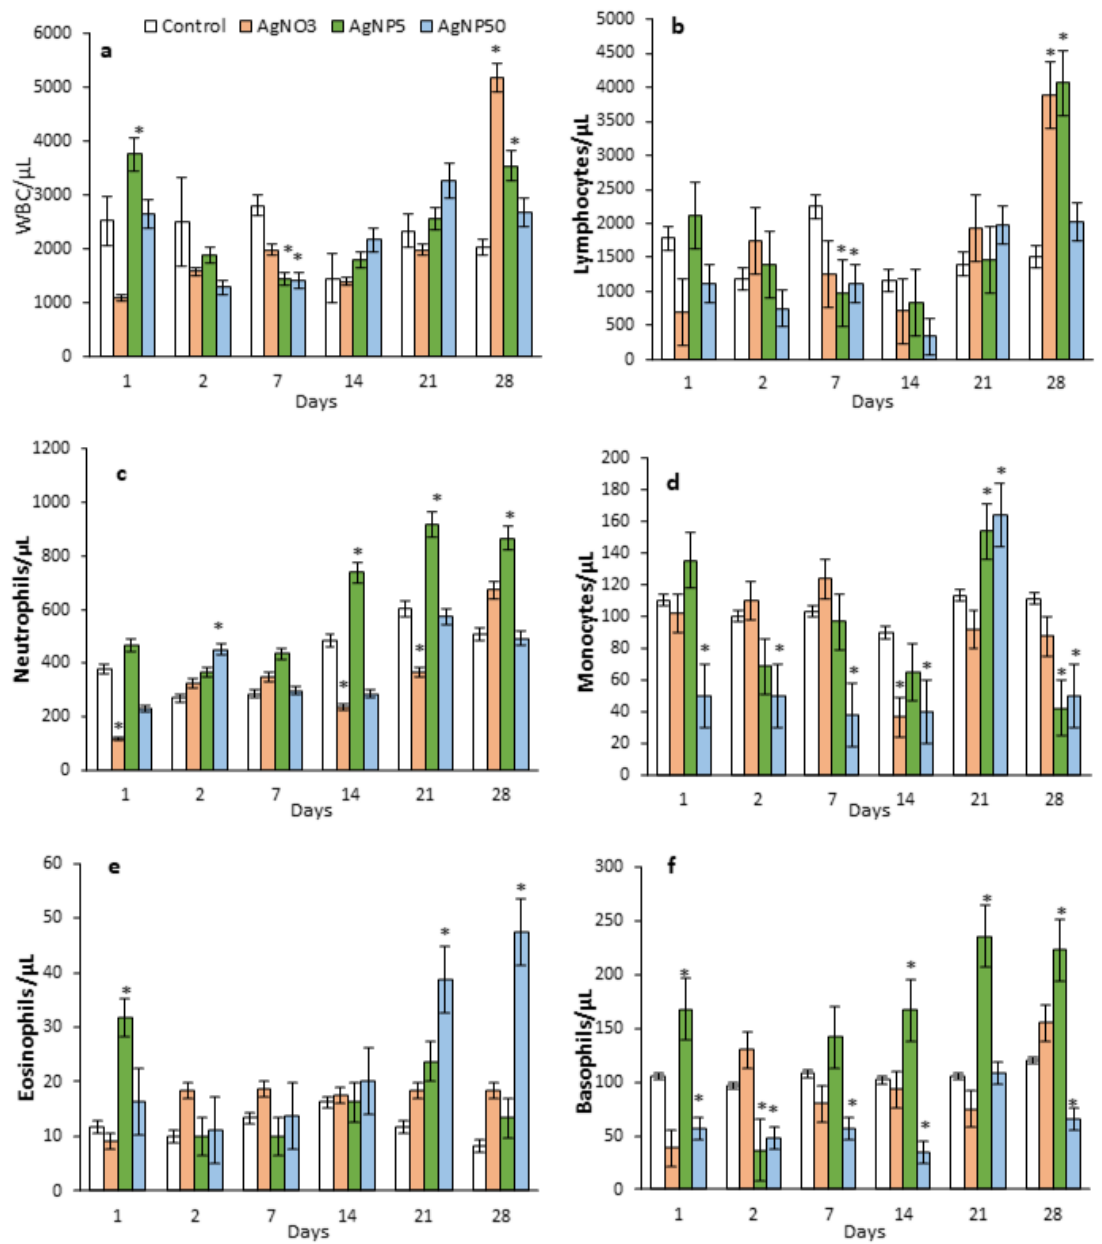
Figure 5. Mice hematology values during a 28-day recovery time after repeated intratracheal instil- lations of saline (control), AgNO 3 , AgNP5 and AgNP50. ( a ) WBC; ( b ) lymphocytes; ( c )